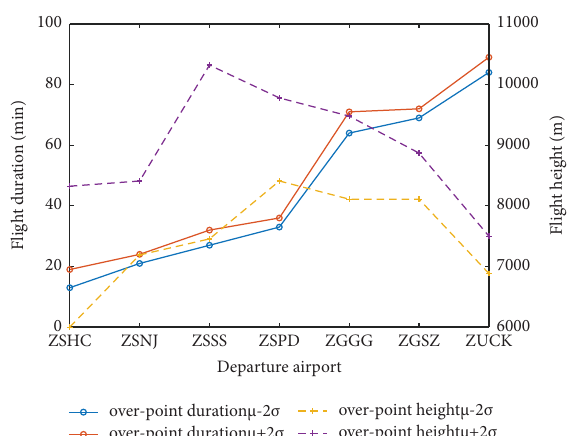
Figure 10: Over ABVIL waypoint fight length fight lower air trafc complexity in the sector. Five hypotheses based on mathematical models are proposed.